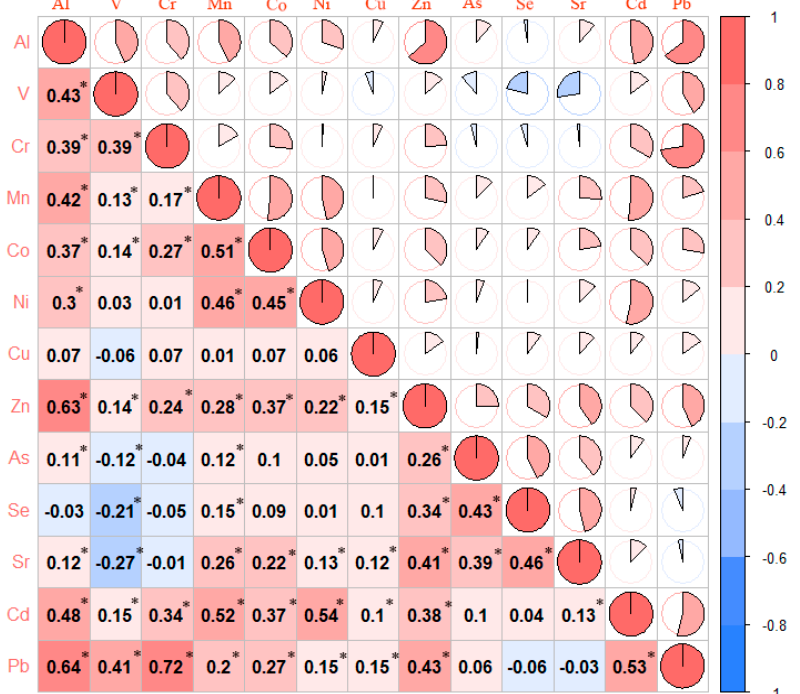
Figure 1. Spearman’s correlation heatmap matrix of ln-transformed serum trace element